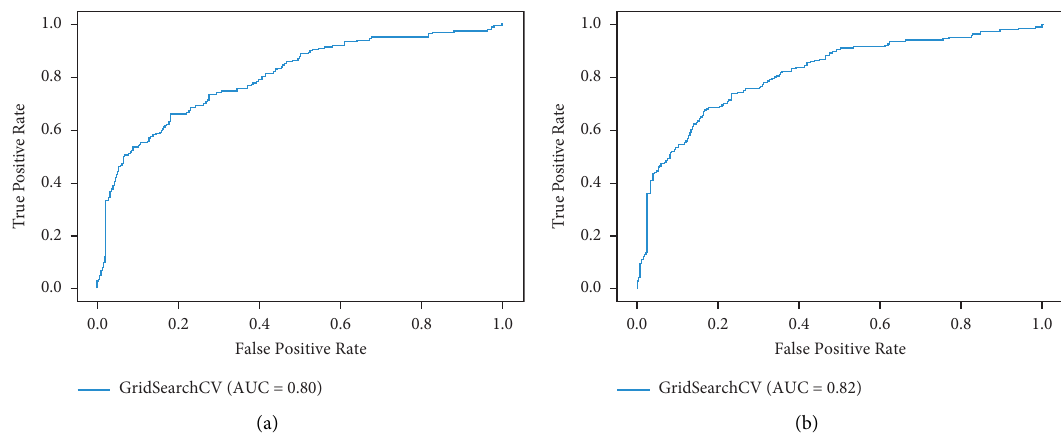
Figure 13: ROC curve and AUC value of low precision and high precision data